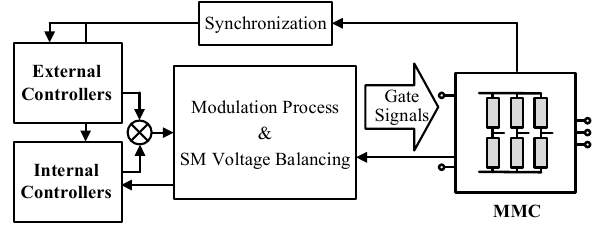
Figure 3. Diagram of MMC control structure.